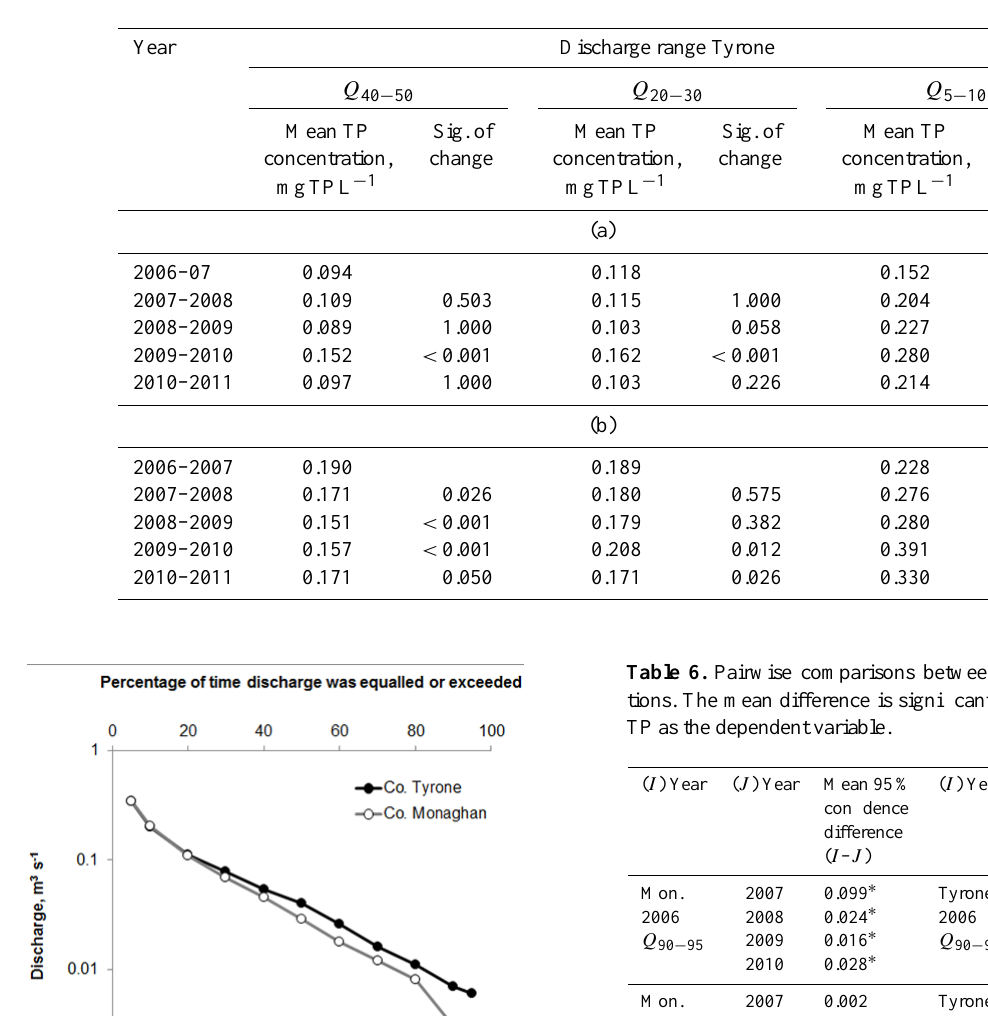
Table 5. Mean TP concentrations at stated discharges ( Q ranges based on Flow Duration Curve analysis) in Tyrone and Monaghan sub- catchments from 2006 to 2011 showing significance of change in concentration from the initial 2006 concentration (significant at ≤ 0.05 value).